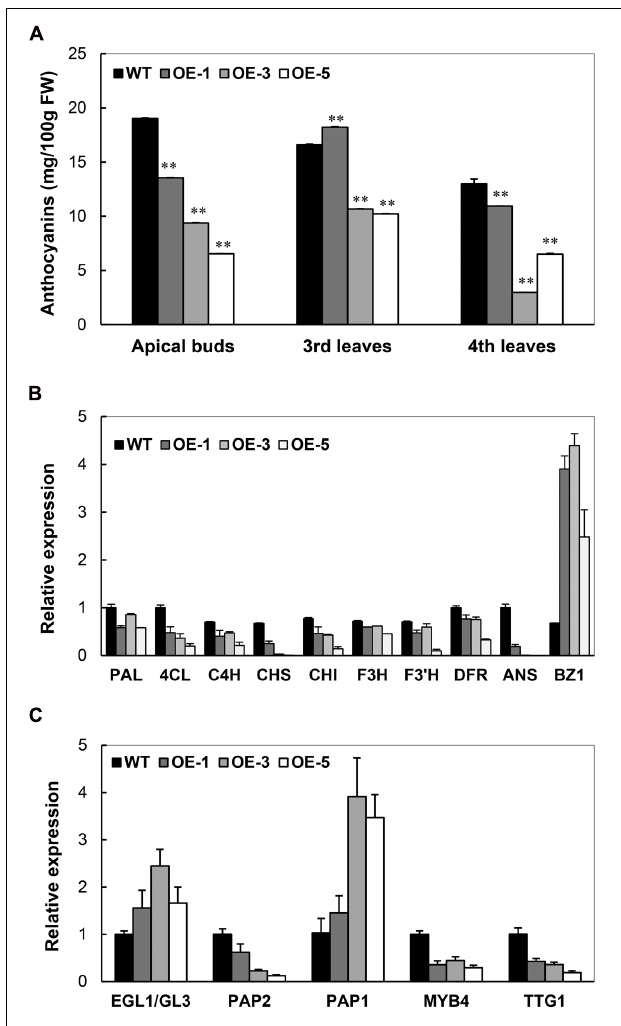
FIGURE 8 | Characterization of anthocyanin biosynthesis in Arabidopsis CBF3 overexpressing cassava. (A) Changes of anthocyanin content in the apical buds, the third and fourth leaves from the top of WT and OE plants. (B) Expressional changes of genes related to